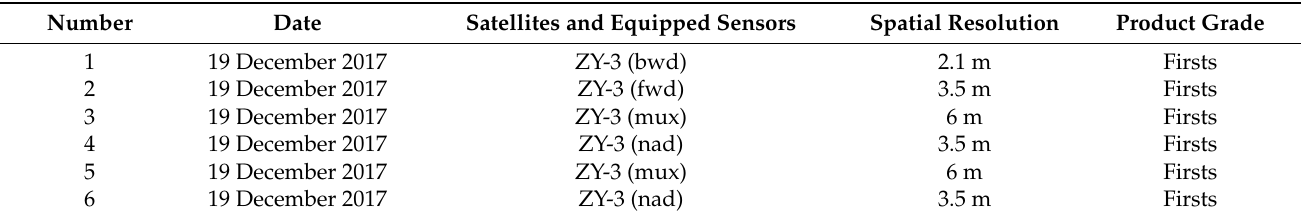
Table 3. List of high-score images of the study area.